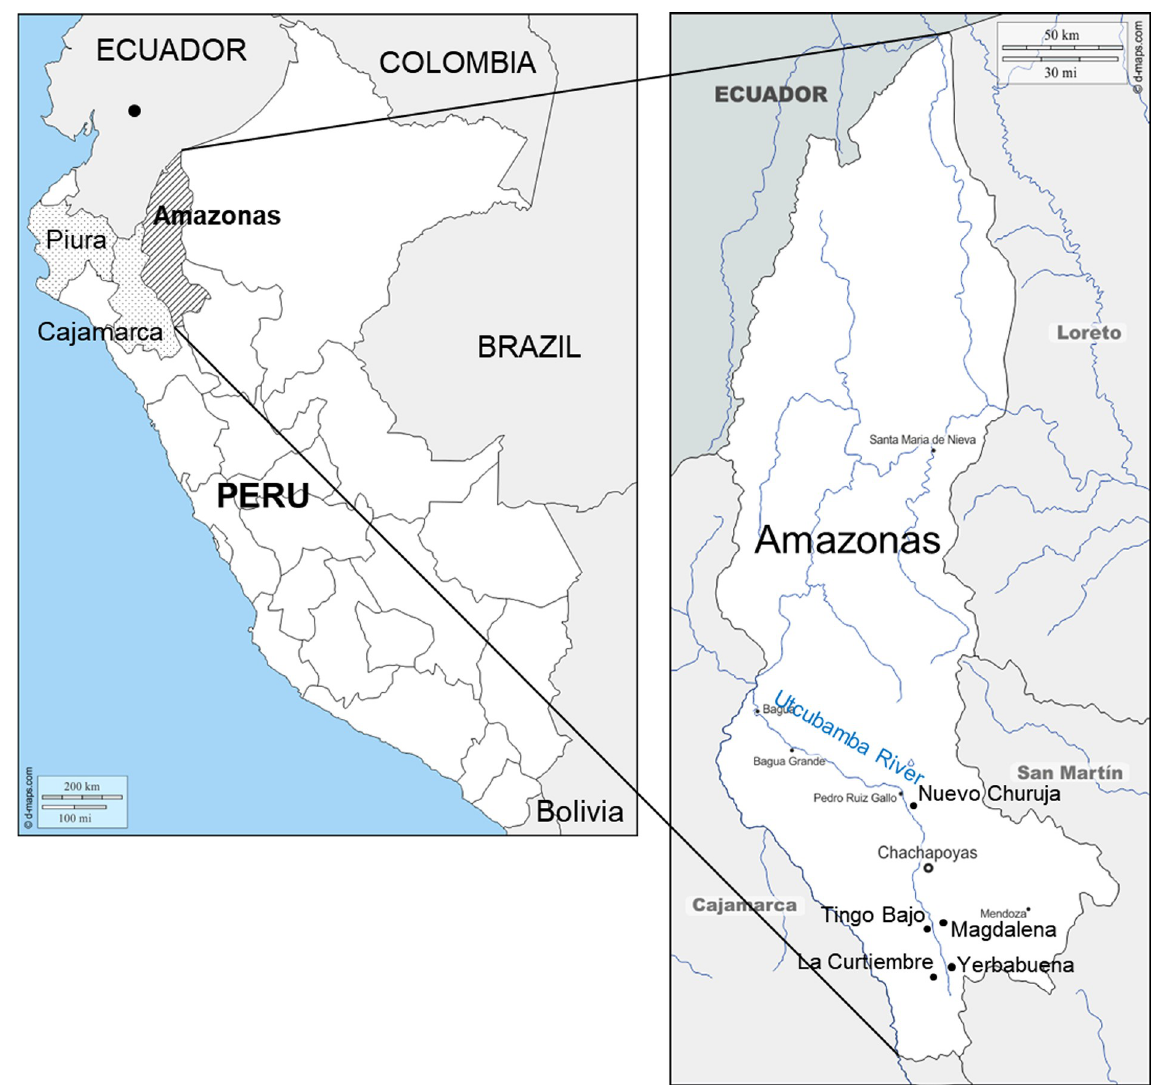
Fig 1. Maps of study areas. Left panel: Department of Amazonas, Peru, is shown by the hatched lines, and Departments of Piura and Cajamarca, Peru, are shown by the small dots. A black spot in Ecuador shows the collection site of Pi . maranonensis in the Province of Chimborazo, Ecuador. Right panel: Sample collection sites in the Department of Amazonas: La Curtiembre, Yerbabuena, Magdalena, Tingo Bajo, and Nuevo Churuja. (Adapted from a map available at https://www.d-maps.com/carte.php?num_car=4764&lang=en and https://www.d- maps.com/carte.php?num_car = 190488&lang = en).